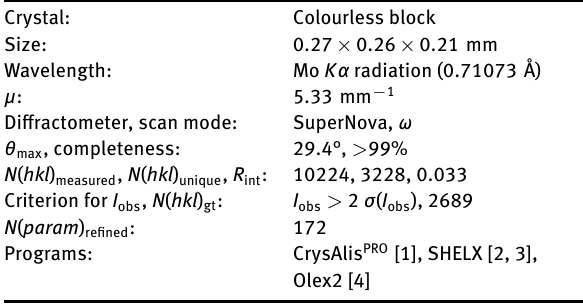
Table 1 contains crystallographic data and Table 2 contains the list of the atoms including atomic coordinates and displacement parameters. Table 1: Data collection and